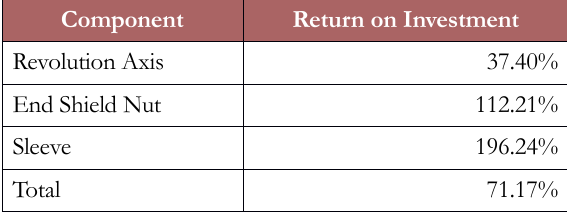
Table 20. ROI in manufacturer side